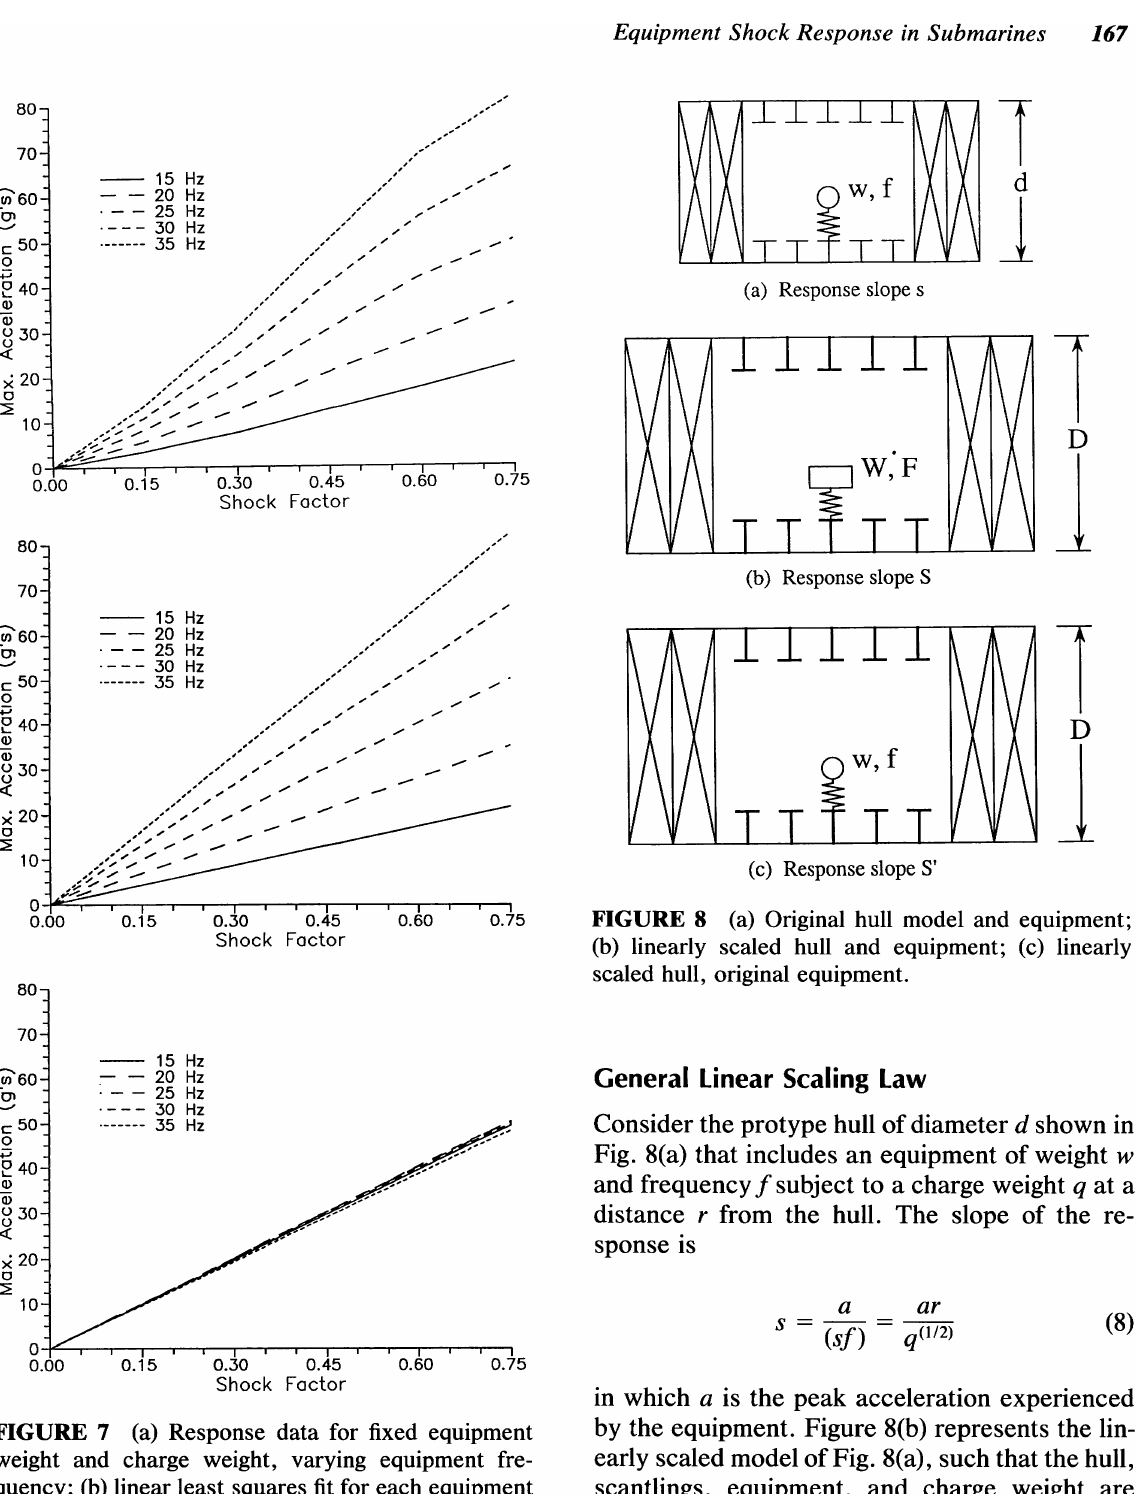
FIGURE 7 (a) Response data for fixed equipment weight and charge weight, varying equipment fre quency; (b) linear least squares fit for each equipment frequency; (c) slopes scaled to the 25-Hz frequency.